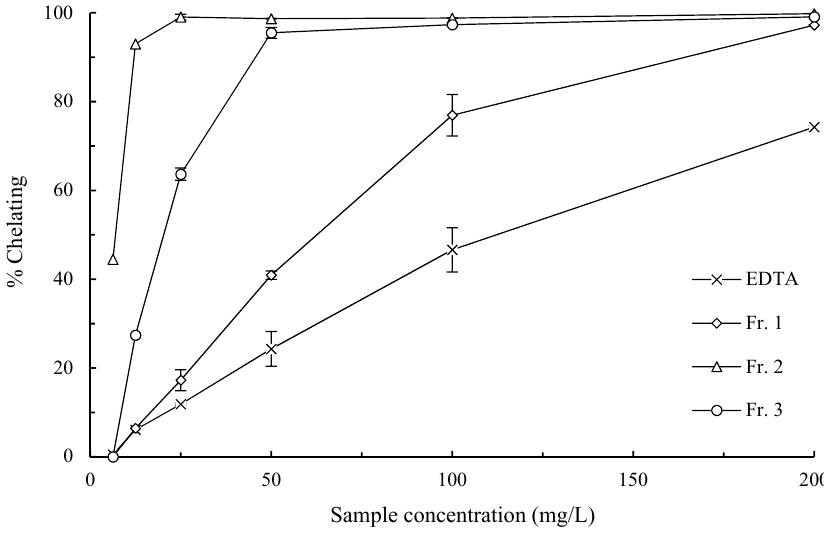
Figure 5. Dose-dependent metal chelating ability of pigment fractions from chestnut shell.